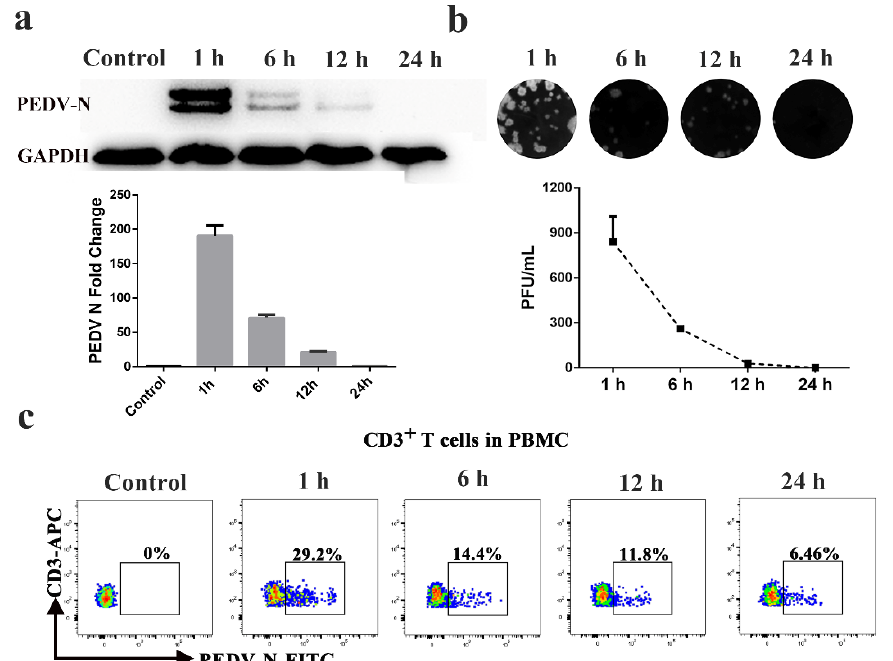
Figure 1. Blood-derived CD3 + T cells could be hijacked by PEDV in vitro. Blood-derived CD3 + T cells were infected with PEDV at different times. The viral loads in blood-derived CD3 + T cells were detected by Western blotting ( a ), plaque assay ( b ), and FACS ( c ). At least three independent exper- iments were performed. PBMC: Peripheral blood monoculear cell; FACS: Fluorescence Activated Cell